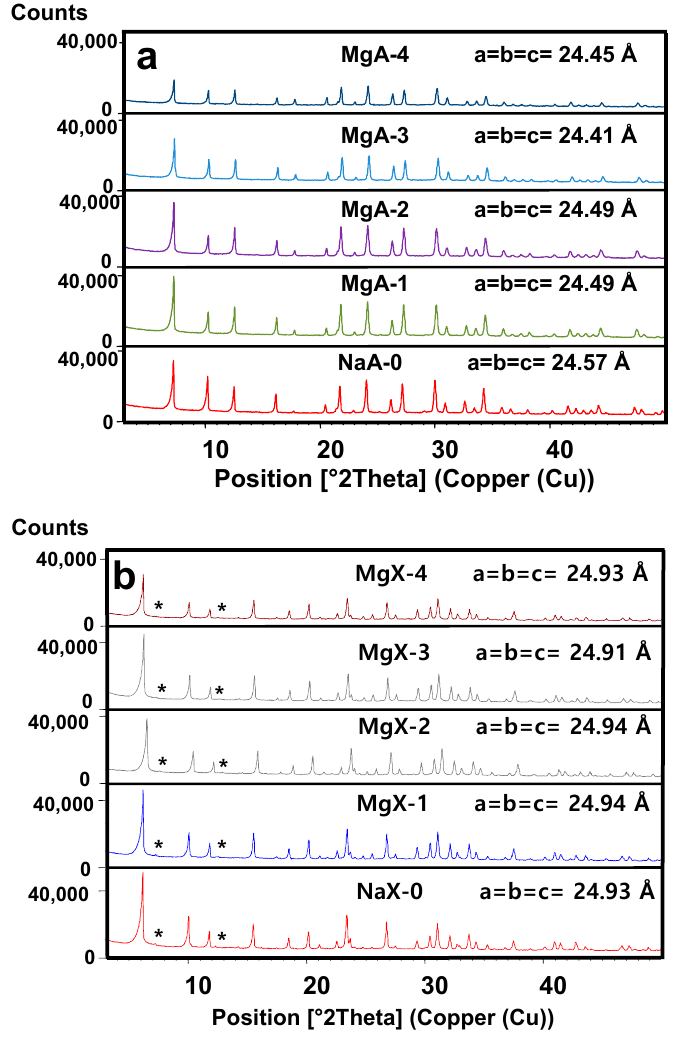
Figure 2. This is a XRD patterns of ( a ) raw and Mg 2 + exchanged LTA-type zeolite; ( b ) raw and Mg 2 + exchanged FAU-type zeolite. * Traces of LTA-type zeolites.